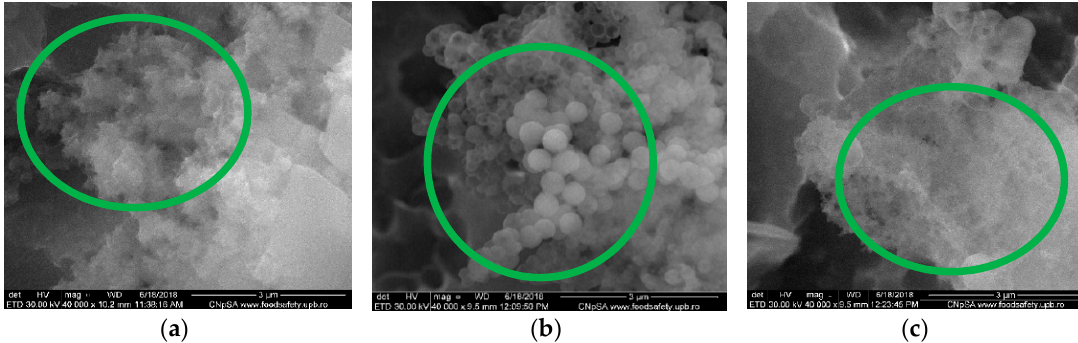
Figure 6. SEM images of the Coll/CaPs thin films deposited by MAPLE with different Zn(II) content ( a ) 0 wt%; ( b ) 1 wt%; ( c ) 2 wt%.